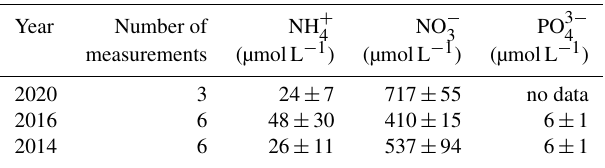
Table 2. Nutrient concentrations in the Dijle River water (data from the Flanders Environment Agency: https://www.vmm.be/data/ waterkwaliteit, last access: 13 November